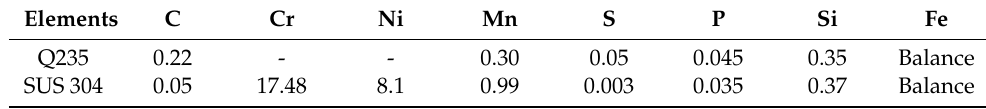
Table 1. Chemical composition of the specimens.